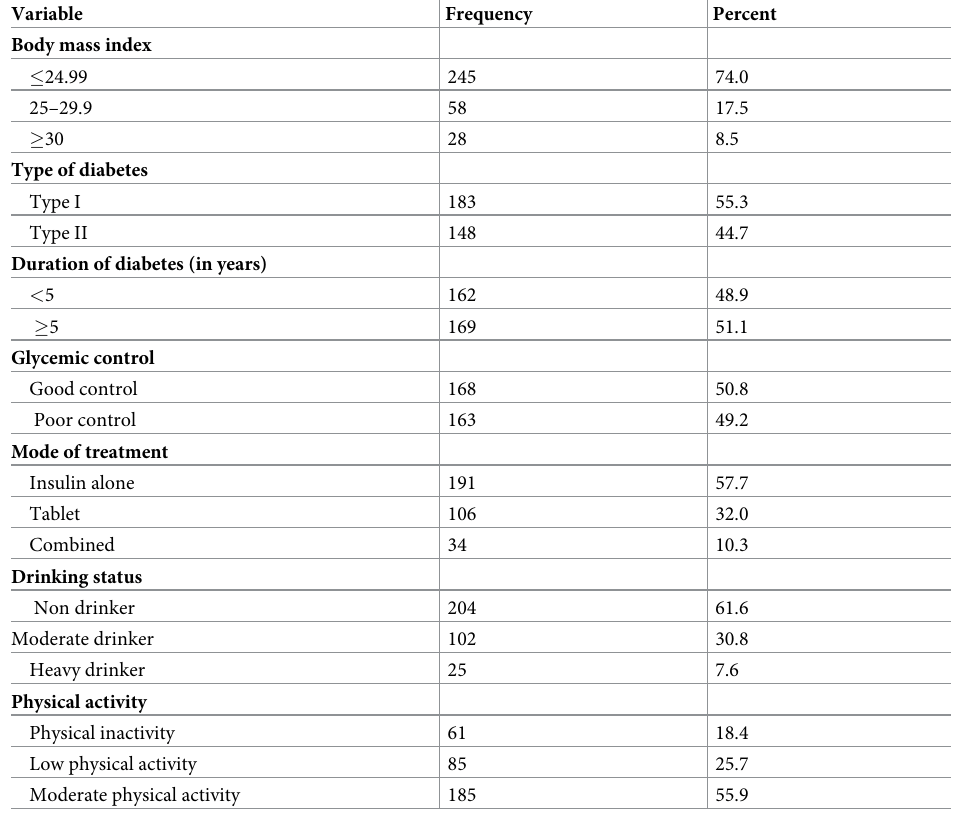
Table 2. Clinical and behavioral characteristics of study participants at Debre Tabor General Hospital Northwest Ethiopia, 2020 (n = 331).